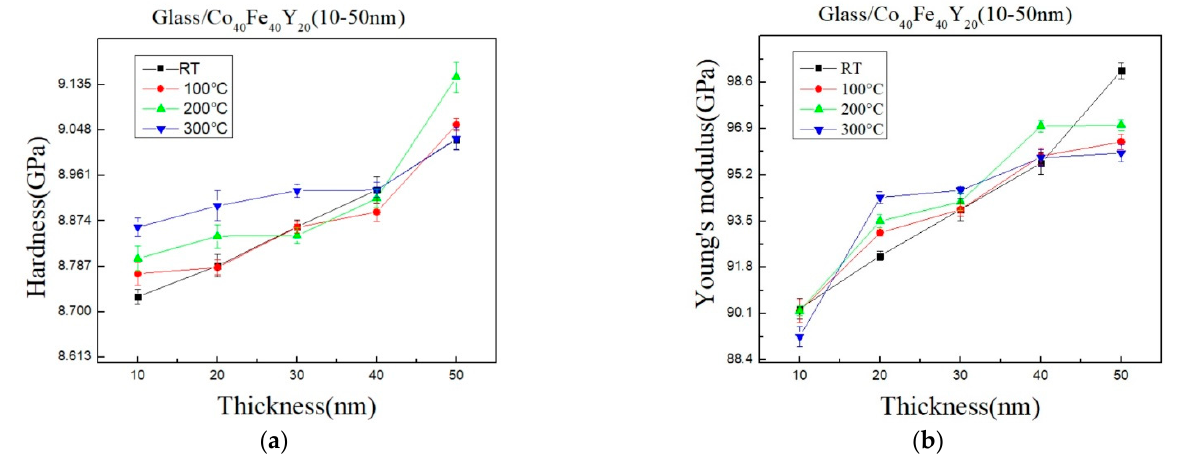
Figure 9. Nano-indentation of CoFeY thin fi lms. ( a ) Hardness and ( b ) Young’s modulus.